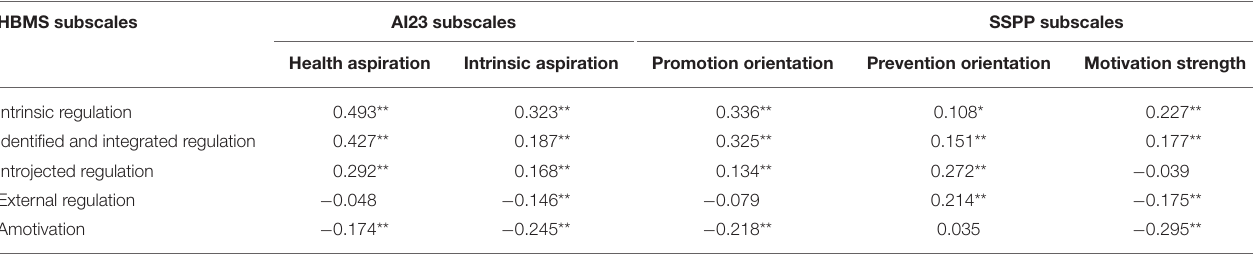
TABLE 6 | Pearson’s and Spearman’s correlation coefficients between the health behavior motivation scale (HBMS) subscales and different dimensions of AI23 and SSPP, Study 2.